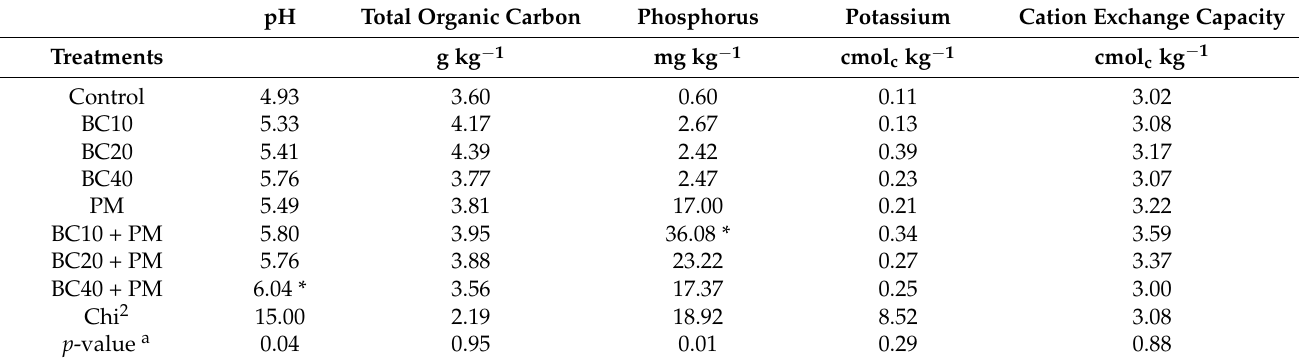
Table 4. Effects of biochar (BC), applied at 10, 20 or 40 t ha − 1 , and poultry manure (PM, 5 t ha − 1 ) on soil chemical properties.